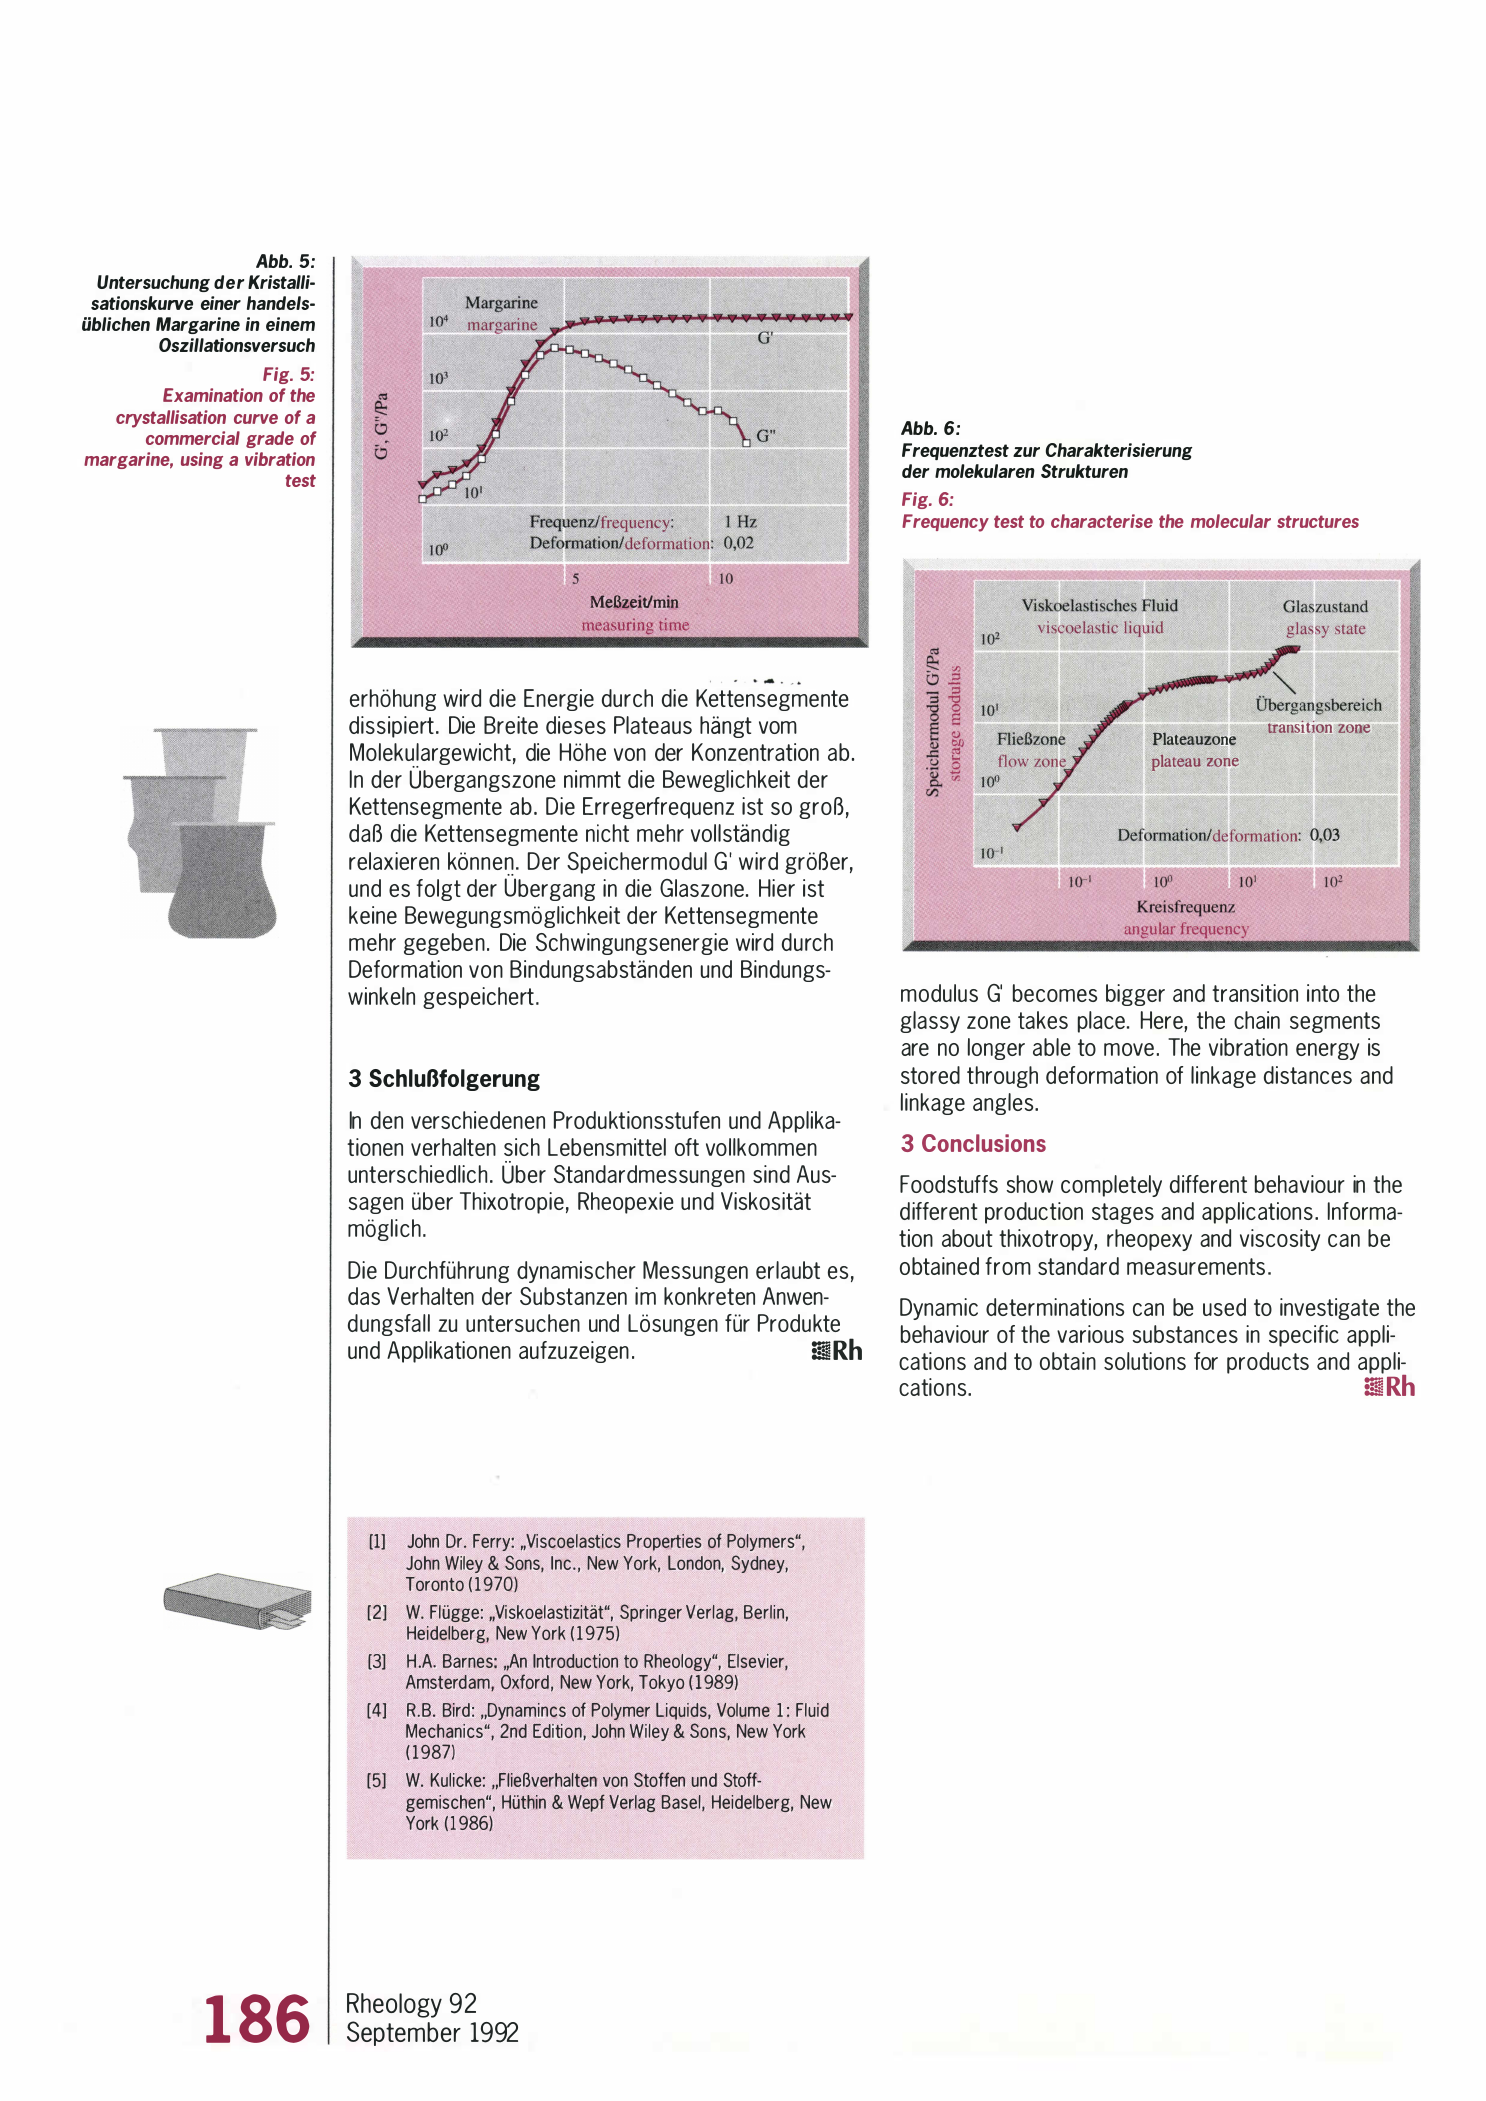
Fig. 5: Examination of the